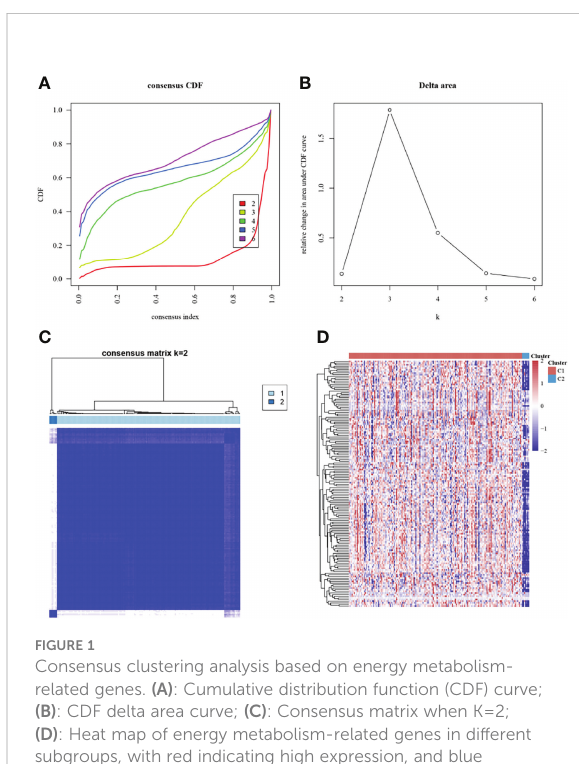
FIGURE 1 Consensus clustering analysis based on energy metabolism- related genes. (A) : Cumulative distribution function (CDF) curve; (B) : CDF delta area curve; (C) : Consensus matrix when K=2; (D) : Heat map of energy metabolism-related genes in different subgroups, with red indicating high expression, and blue indicating low